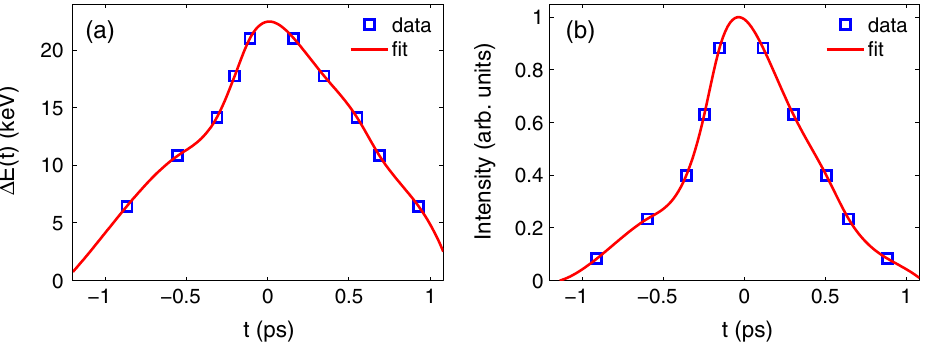
From Fig. 8 we obtain (cid:1) E ð t Þ at several discrete values and the retrieved time-resolved energy modulation is shown in Fig. 9(a). Accordingly, the peak energy modula- tion is quantified to be about 22.5 keV. Similarly, the